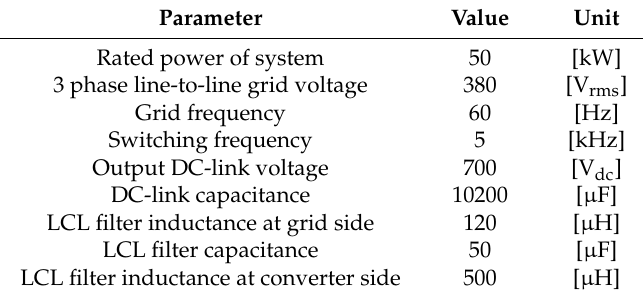
Table 1. Simulation parameter of DC distributed